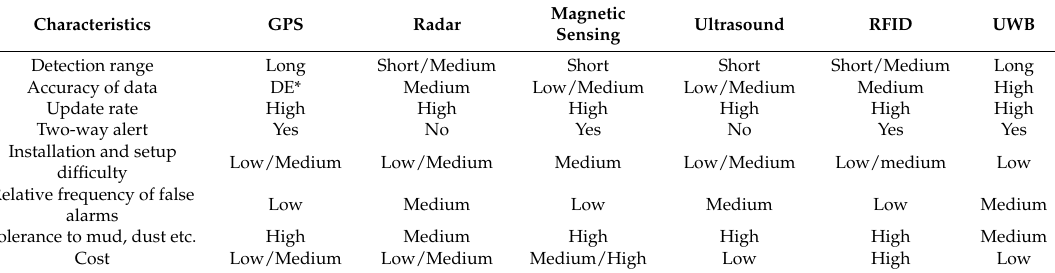
Table 3. Comparison of the characteristics of proximity sensor technologies